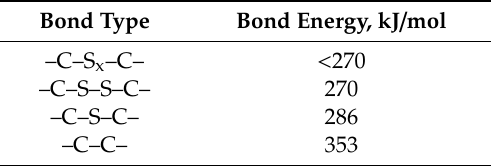
Table 1. Energy of bonds in sulfur cured